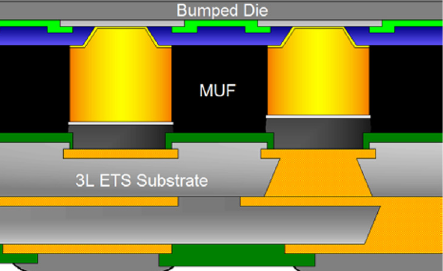
Figure 2. Schematic of the FCCSP test